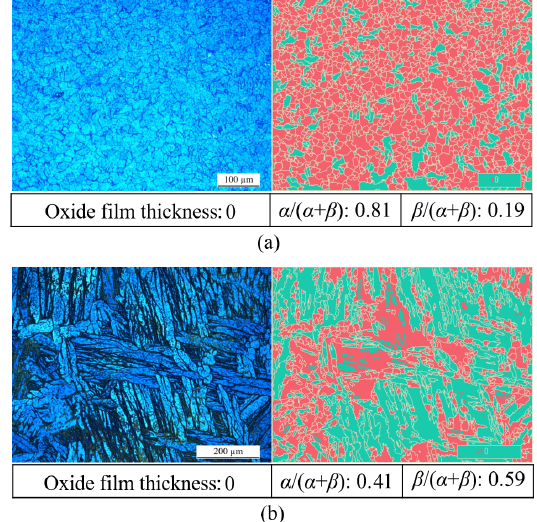
Fig. 6 Detection results of oxide film boundary and segmentation results of ˛˛˛ phase and ˇˇˇ phase by the edge detection method based on deep learning proposed in Ref.